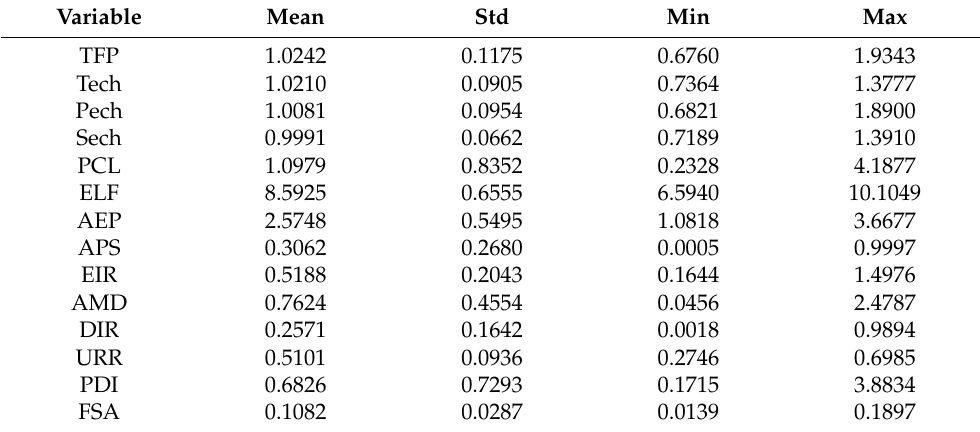
Table 2. Descriptive Statistics.